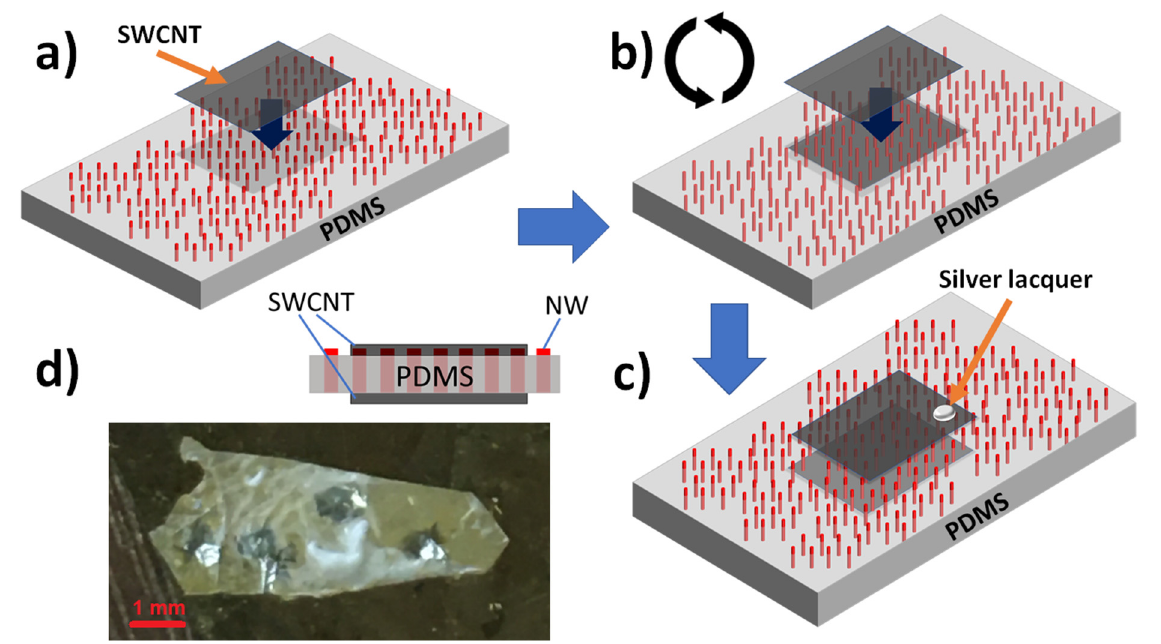
Figure 4. ( a – c ) Workflow schematic of single-walled carbon nanotubes (SWCNT) contact application for flexible LED, ( d ) photo of a representative flexible LED. The insert schematically shows the cross-section of the membrane NWs-based LED.